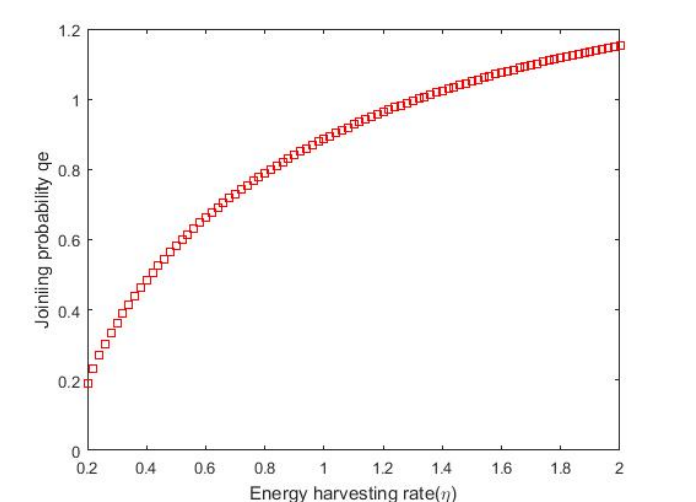
Figure 7. Equilibrium-joining probabilities vs. η when λ = 0.4, α = 0.2, µ = 1, β = 0.5, θ = 0.7, C = 1, R = 15.